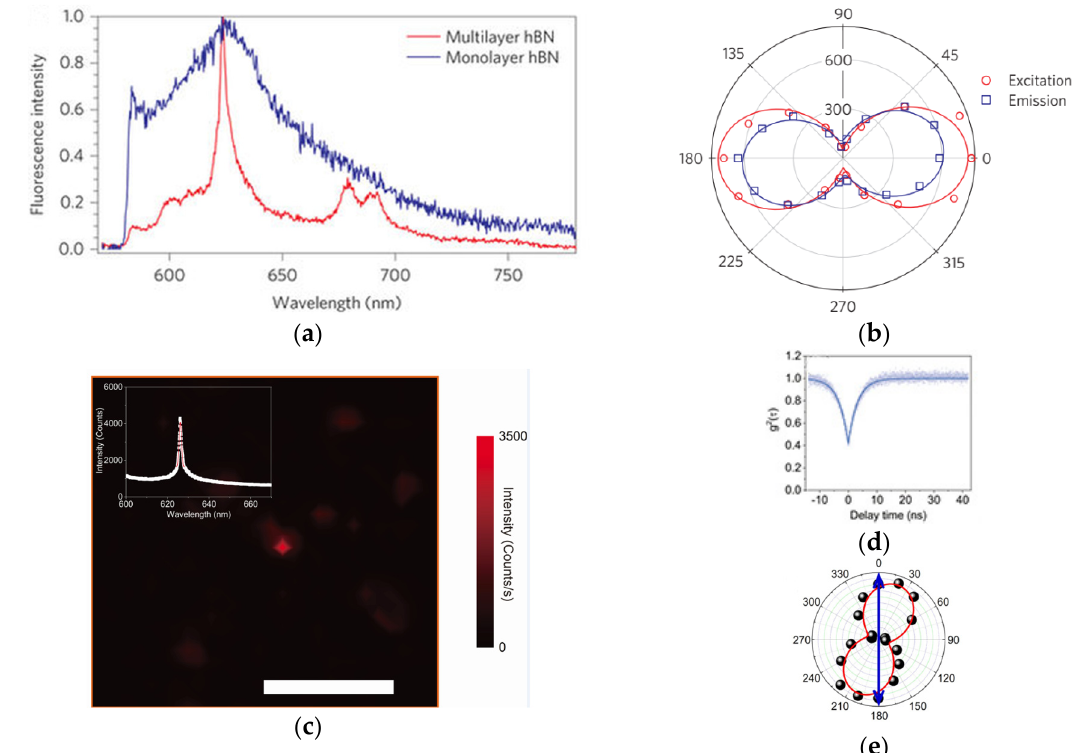
Figure 3. ( a ) Emission spectra of hBN monolayer and multilayers and ( b ) excitation and emission polarization curves of a single defect in hBN multilayer created by electron beam irradiation. ( c ) Photoluminescence (PL) intensity mapping of laser irradiated regions in hBN flakes. Inset: a typical PL spectrum taken from the bright spot. ( d ) Second order autocorrelation function curve from individual color centers in hBN flakes. ( e ) Emission polarization curve (black balls) with cos 2 ( θ ) function fitting (red solid line). The excitation is vertically polarized (blue solid line). Measurements were conducted using a 371 ± 5 nm, 50 mW laser at room temperature. Figures reproduced from ( a , b )